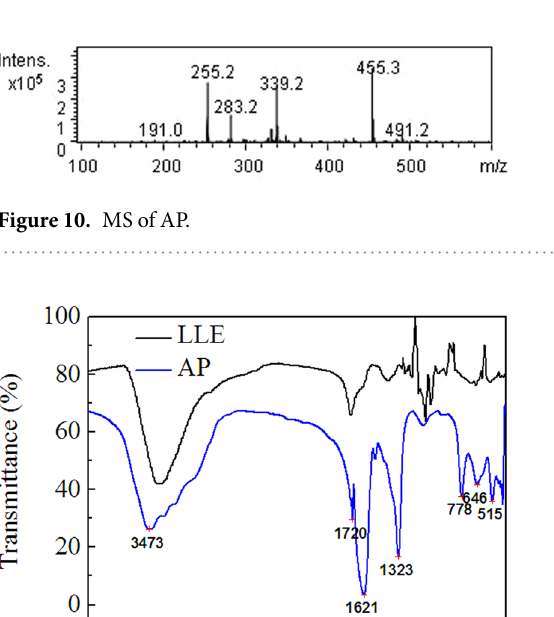
Figure 9. HPLC chromatograms of standard ursolic acid and AP.